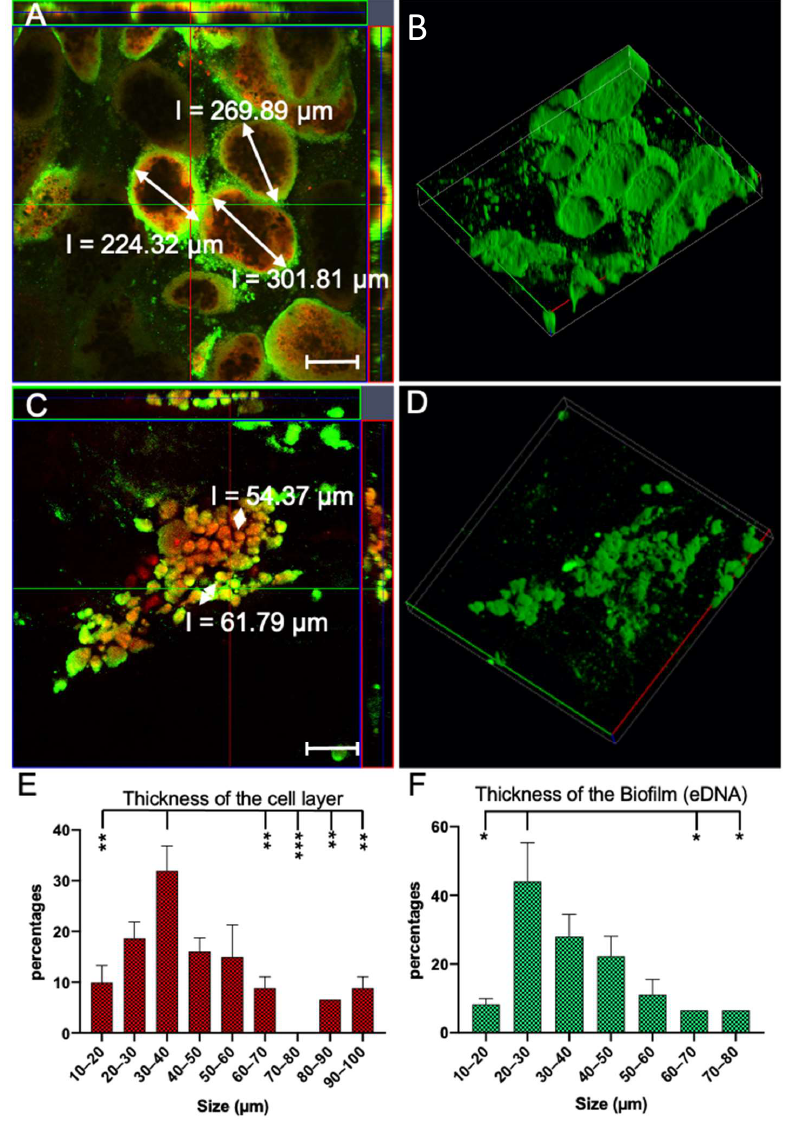
Figure 9. Confocal laser scanning microscopy of clusters formed by Pseudomonas aeruginosa in the presence of nickel and nickel oxide nanoparticles after 32 h. For this assay, the dye TOTO-1 was used for staining the eDNA biofilm (green) and Syto™60 as a counterstain (red). The cluster formed in the medium with nickel oxide had an average diameter of 200 to 300 µ m. Furthermore, the bacteria clustered around the nanoparticles and formed a biofilm towards the outside. In this mechanism, some bacteria sacrificed themselves and formed a biofilm so that other bacteria survived without contact with the nanoparticles in the medium ( A ). The 3D arrangement of A ( B ). This picture shows the generation of clusters in the presence of nickel. The nickel clusters were much smaller compared to the nickel oxide and had an average diameter of 50 ± 10 µ m ( C ). The 3D arrangement of C ( D ). statistical analysis of total cell layer thickness. This graph shows the thickness of cell layer (live and dead) of P. aeruginosa that are surrounded nickel oxide NPs cluster ( E ). Statistical analysis of the formed biofilm (eDNA). This graph shows the thickness of formed biofilm of P. aeruginosa , which are surrounding nickel oxide cluster ( F ). Statistical analysis of diagrams ( E , F ) shows that the thickness of the cell layer is mostly in the range of 30 to 40 µ m. The thickness of the biofilm is mostly in the range of 20 to 30 µ m. Here, the X -axis represents the thickness of the cell layer or biofilm and the Y -axis shows the relevant percentage. Definition of statistical significance: GP: 0.1234 (ns), 0.0332 (*), 0.0021 (**), 0.0002 (***). Scalebar = 200 µ